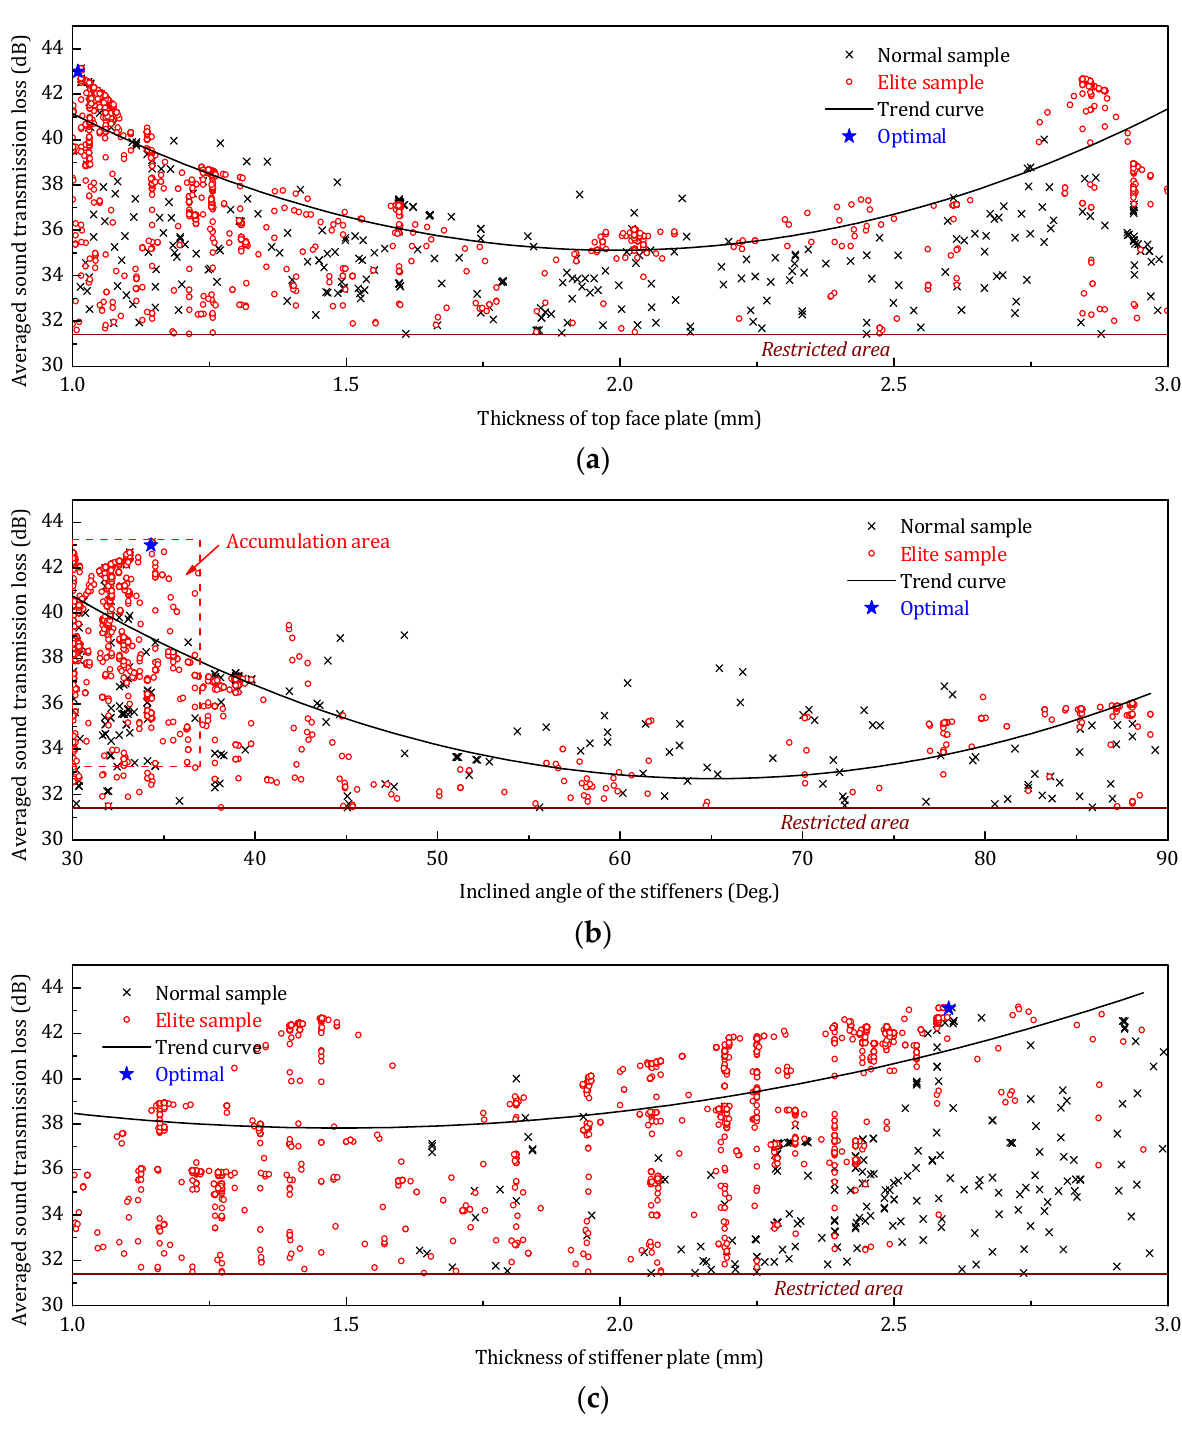
Figure 27. Optimization samples distribution of three design parameters (high-frequency range). ( a ) Optimization samples distribution of h t ; ( b ) Optimization samples distribution of φ ; ( c ) Optimization samples distribution of h s .